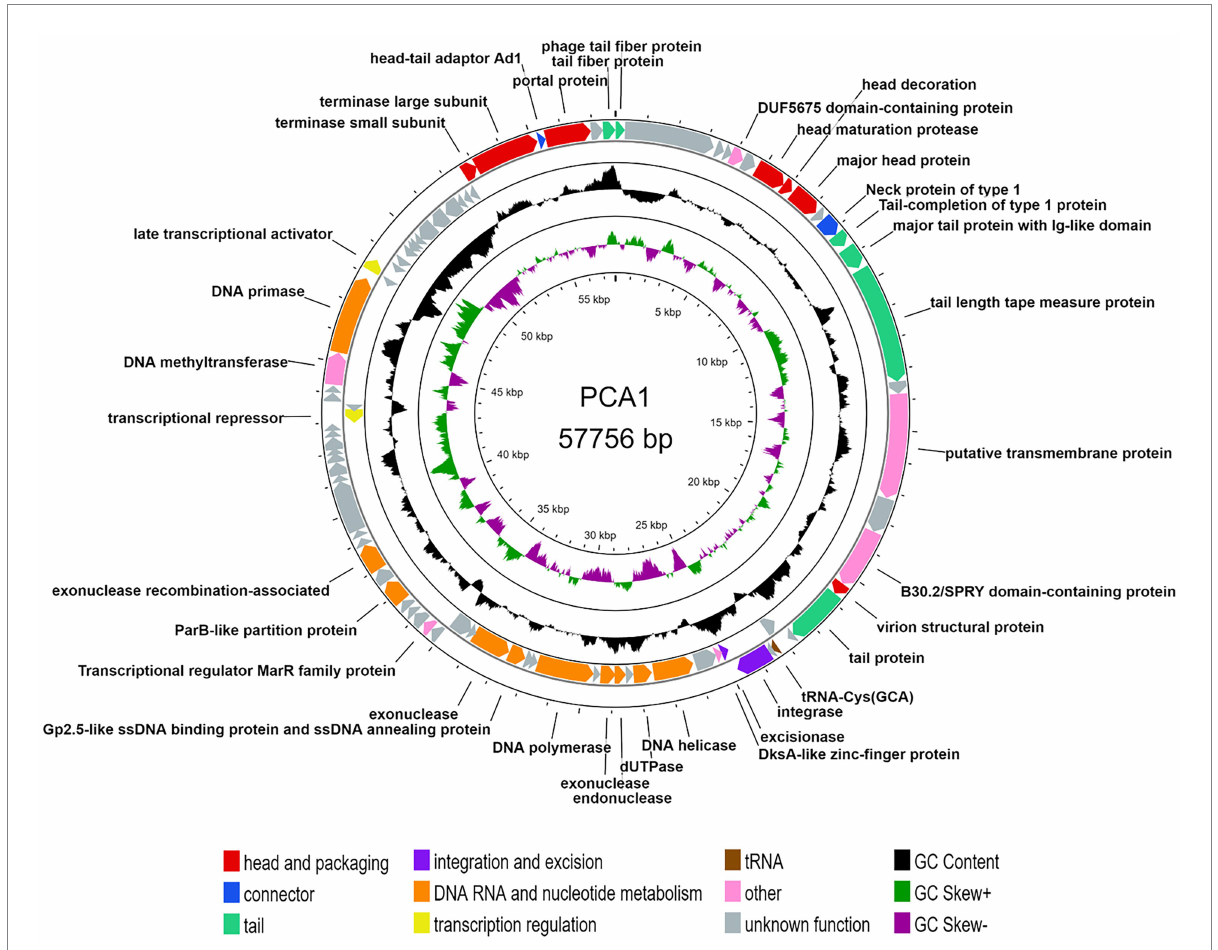
FIGURE 2 Circular genomic map of bacteriophage PCA1. The two outer rings show 84 ORFs and one tRNA gene, based on the direction of transcription and colored by their different functional categories: head and packaging (red), connector (blue), tail (teal), integration and excision (purple), DNA RNA and nucleotide metabolism (orange), transcription regulation (yellow) and other proteins (pink), tRNAs (brown), and hypothetical proteins (gray). The two inner rings with histogram bars show GC content (black), positive GC skew (green), and negative GC skew